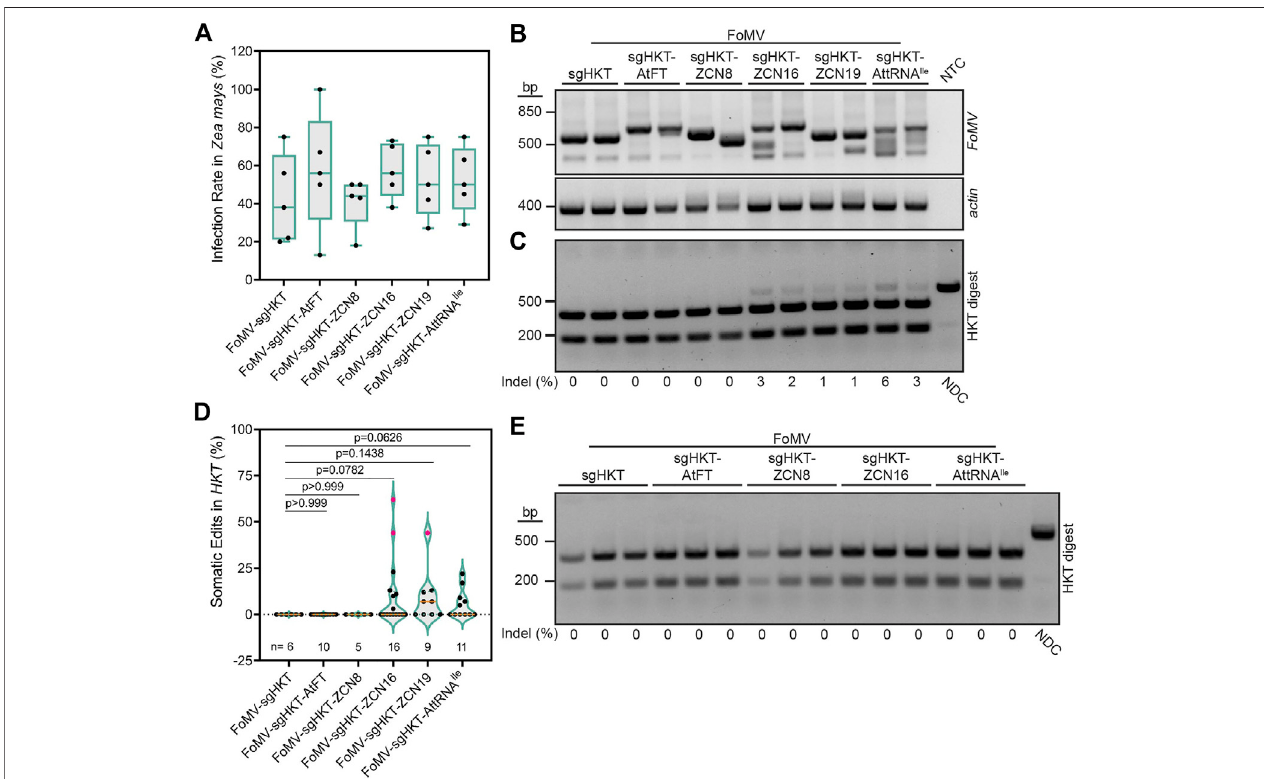
FIGURE 2 | Effects of RNA mobility signals on FoMV-induced mutations in ZmHKT1 . (A) Percentage of Cas9 maize plants displaying systemic FoMV infection 6 weeks post-injection, as determined by RT-PCR. Data are represented as box plots indicating the 25% – 75% interquartile range, split by a median line. Whiskers representmaximumandminimumvalues.Aone-wayANOVAindicatednosigni fi cantdifferencesininfectionratesbetweentreatments( p =0.7024). (B) RT-PCRanalysis ofFoMVinsystemic Z.mays leaves6 weekspost-infection.Primersweredesignedto fl anktheinsertionsitetoassessstabilityofsgRNAandsgRNA-mobilitysignal insertions. Intact FoMV:sgRNA is represented by a 571 bp amplicon, FoMV:sgRNA-AtFT, FoMV:sgRNA-ZCN8, FoMV:sgRNA-ZCN16, and FoMV:sgRNA-ZCN19 are represented by a 673 bp amplicon, and FoMV:sgRNA-AttRNAIle is represented by a 646 bp amplicon. ZmActin was used as an internal control, and NTC is the no template control. (C) Representative gel of FoMV-induced somatic mutations in ZmHKT1 (see Supplementary Figure S2 for additional gels). A fragment of ZmHKT1 containing the sgZmHKT target site was PCR ampli fi ed from genomic DNA isolated from systemic leaf tissue, 6 weeks post-inoculation. The resulting amplicons were digestedwith Xcm Irestrictionendonucleasetoassessthepresenceofindelsdisruptingtherestrictionsite.Thepercentageofsomaticmutationsdetectedforeachplant isprovidedunderneaththegelimage,andwerecalculatedfromfragmentintensitiesusingImageJ.Datapointsarefromtworeplicateswithnrepresentingthenumberof plants. The non-digested control (NDC) represents the wild type 732 bp ZmHKT1 amplicon and undigested amplicons containing indels. The absence of indels at the Xcm Isiteresultsinfragmentsresolvingat228and504 bp. (D) Percentageofsomaticmutationsin ZmHKT1 ampliconsdigestedwith Xcm Iwerequanti fi edbyImageJto calculate the ratio of non-digested to digested amplicons. Results are reported as violin plots split by a median line, with dotted lines representing the fi rst and fourth quartiles,datapointsarereportedfromtworeplicates.Pairwise p -valuesareindicatedfromstatisticalanalysisbyone-wayANOVAandposthocStudent ’ st-testforeach comparison.PinkdatapointsweredeterminedtobeoutliersusingtheROUTmethodwithQ=1%. (E) Germlinemutationsin Z.mays progenyproducedbyparentplants infectedwiththeindicatedFoMVconstructs.TheNDCandmutant ZmHKT1 ampliconsmigrateto732 bp,whereasampliconscontainingnomutationsarefullydigested by Xcm I producing fragments that resolve at 228 and 504 bp. Experiments were conducted two